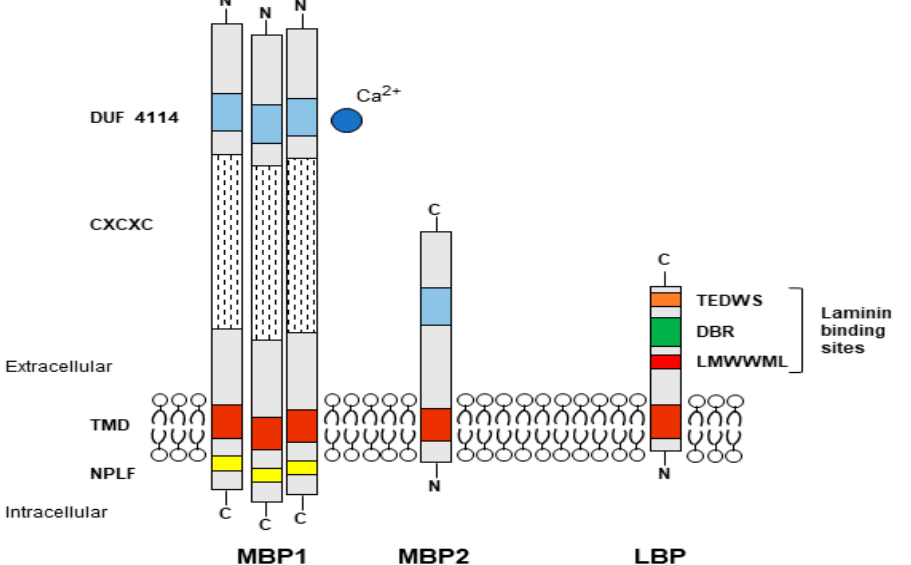
Figure 1. Schematic drawings of Acanthamoeba adhesins. Mannose binding protein 1 (MBP1) and 2 (MBP2); Laminin binding protein (LBP). The putative site for mannose binding in both MBP1 and MBP2 should be in the DUF 4114 region and involve a divalent cation. For LBP, the laminin binding sites correspond to the palindromic motif, the direct binding region (DBR), and the TEDWS motif. See text for more details and explanation.